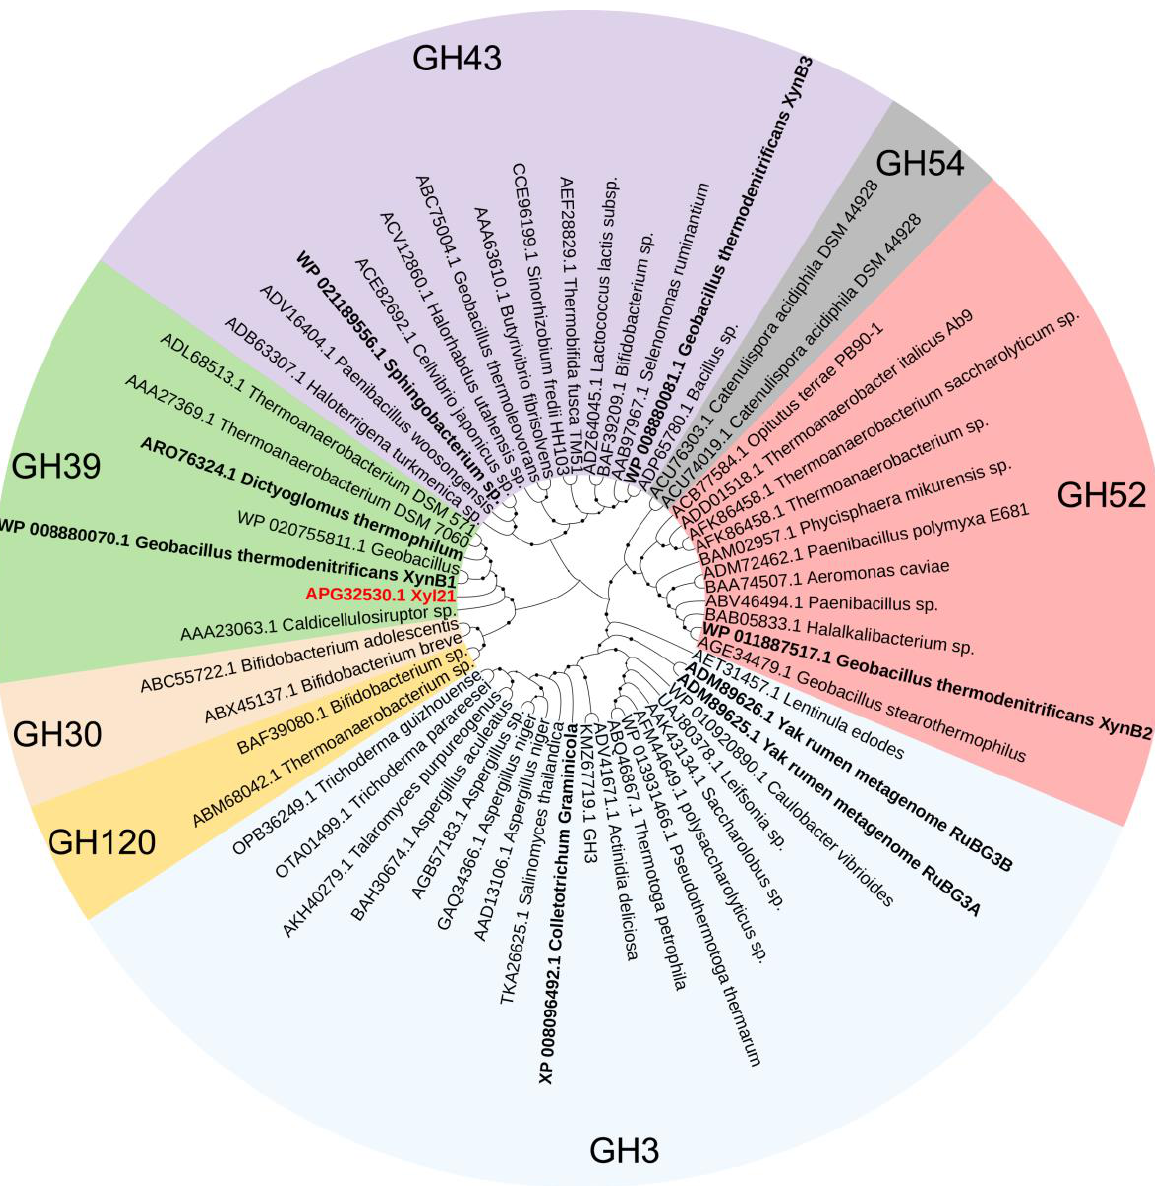
Figure 1. The phylogenetic analysis of the amino acid sequences of β -xylosidases from seven families. The phylogenetic tree was constructed using the neighbor-joining method in MEGA and separated into seven clusters that correspond to the seven families. The bootstrap values from 1000 replications are indicated by the size of the black circle symbols. Xyl21 is highlighted in red letters, and other highly tolerant xylosidases are marked in bold black letters.